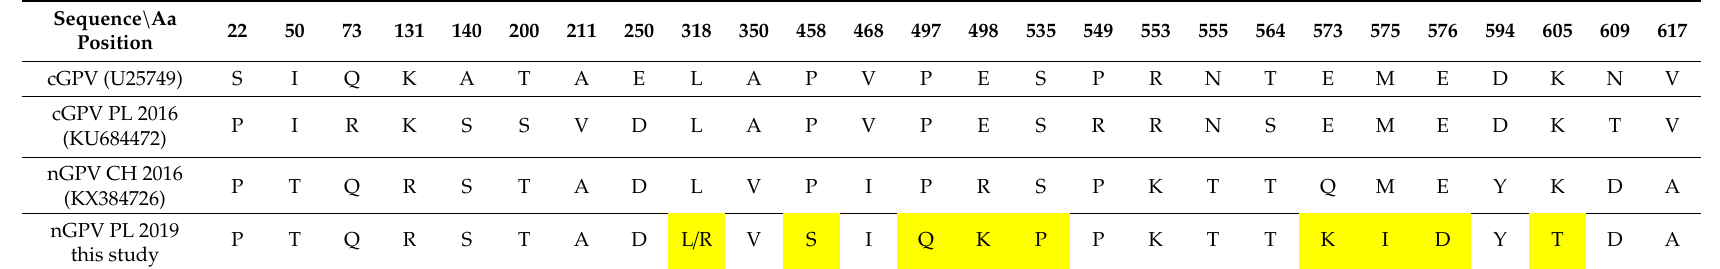
Table 3. Amino acid substitutions in Vp1 Rep